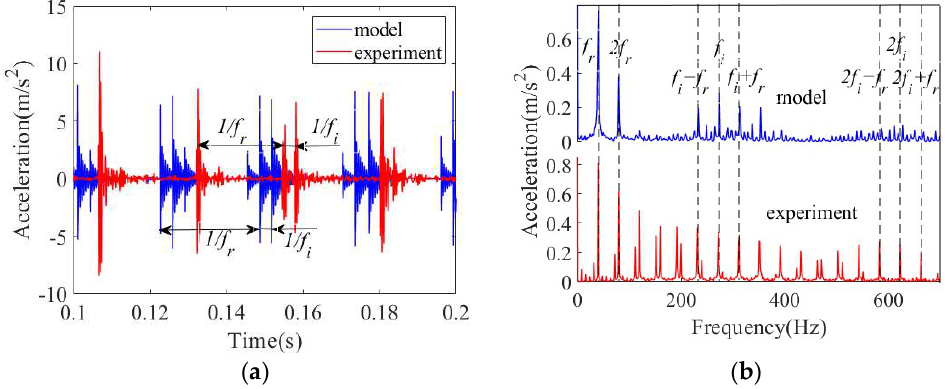
Figure 7. The comparison results for time-domain and frequency responses under inner ring defect: ( a ) acceleration signals; ( b ) envelope